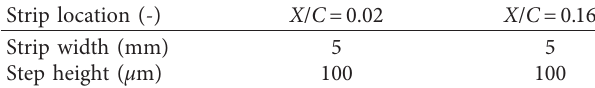
Table 1: Step location on the compressor blade.